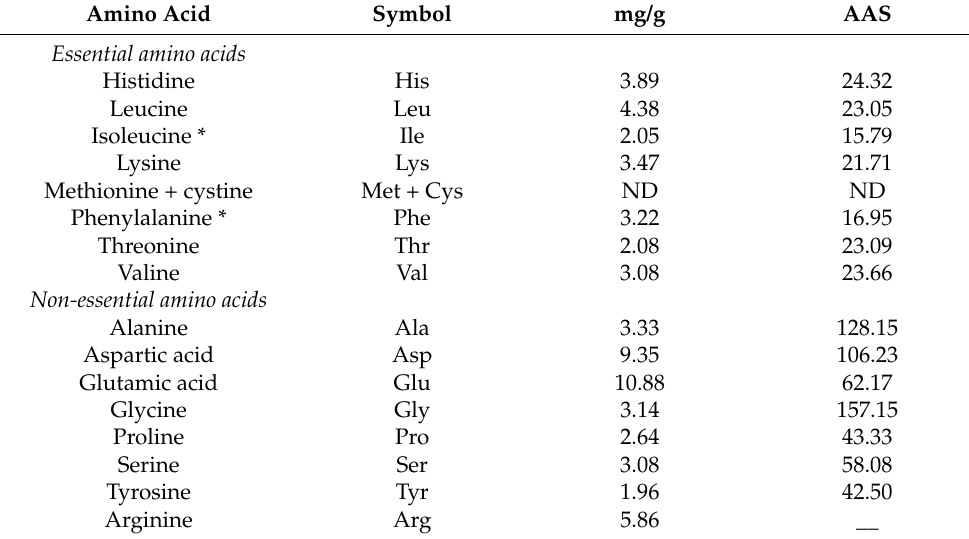
Table 2. Amino acid content of sea